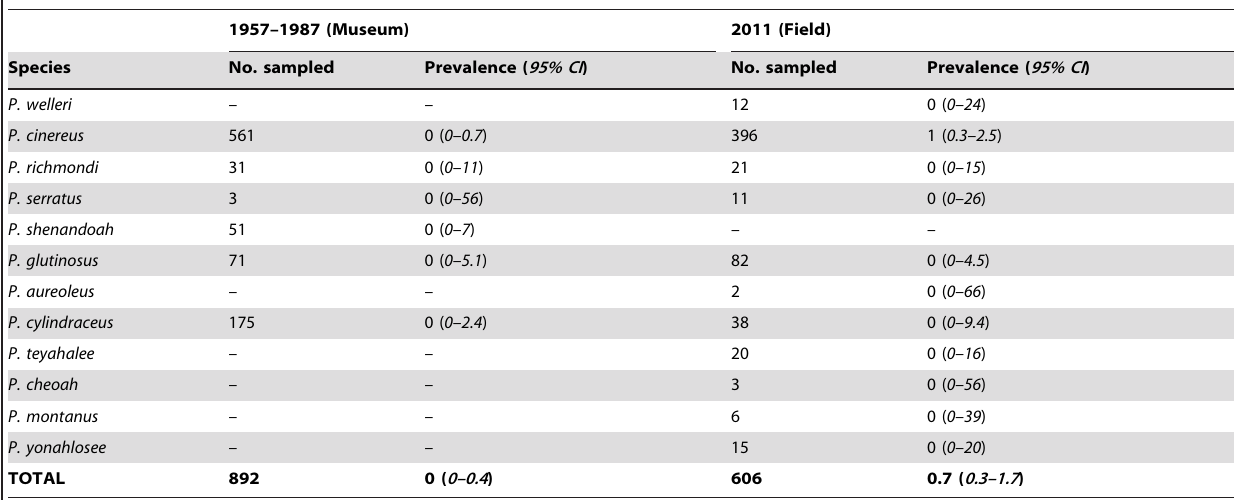
Table 1. Results of Bd testing for 12 species of Plethodon species.